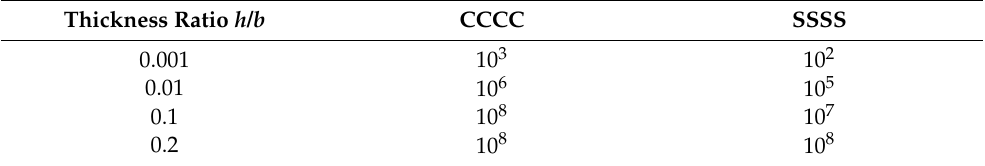
Table 2. Optimal values of the stiffness k for boundary springs of laminates (0 ◦ , 90 ◦ , 0 ◦ ).